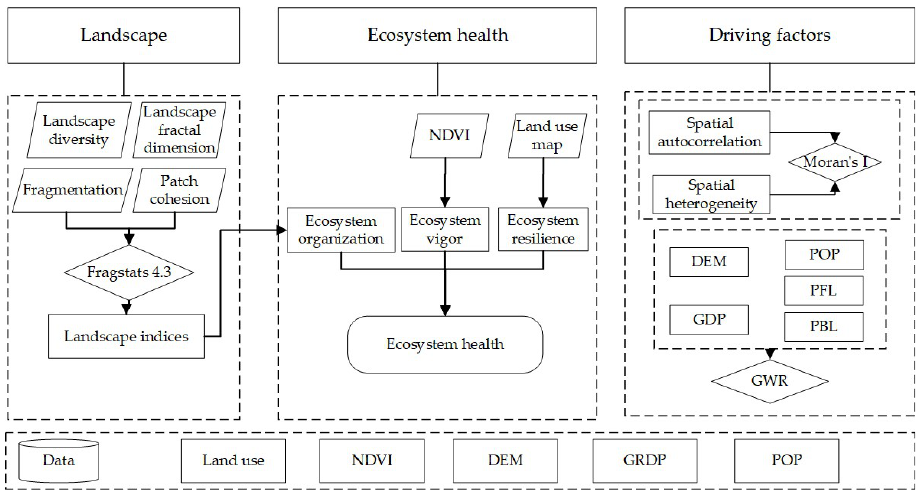
Figure 2 . Overall framework of the research. Figure 2. Overall framework of the